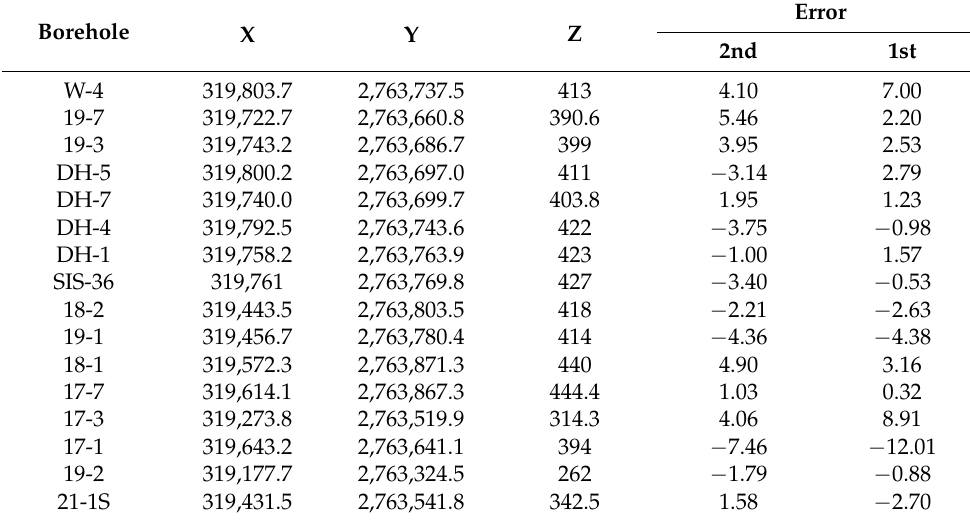
Table 1. Error of the first- and second-order polynomial regression models in comparison with the real data from the boreholes in Zone 1. Z represents the elevation of the sandstone top (key bed). Borehole